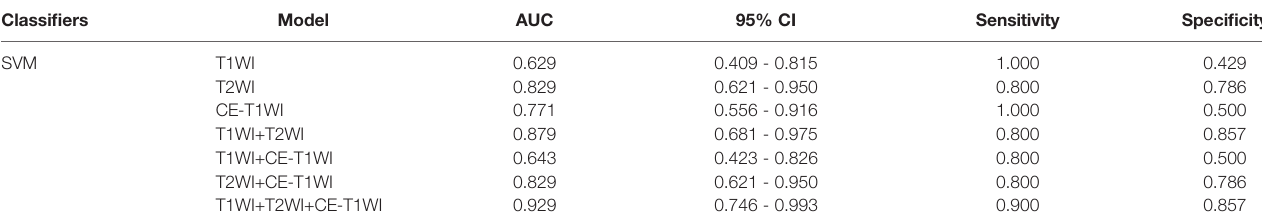
TABLE 10 | The ROC curve of different models of SVM-classi fi er in the validation